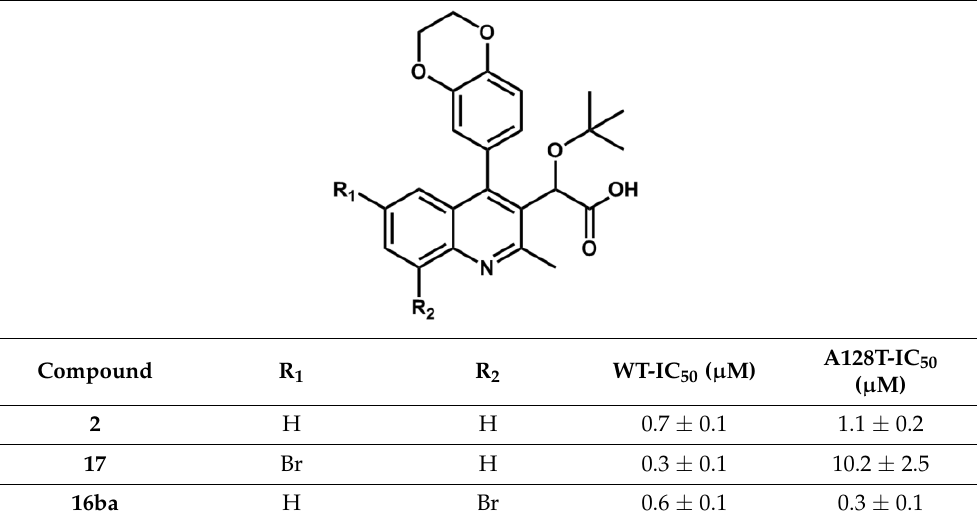
Table 5. Antiviral activities IC50 of 6 or 8-substituted benzodioxanequinolines against the WT and A128T IN mutant.